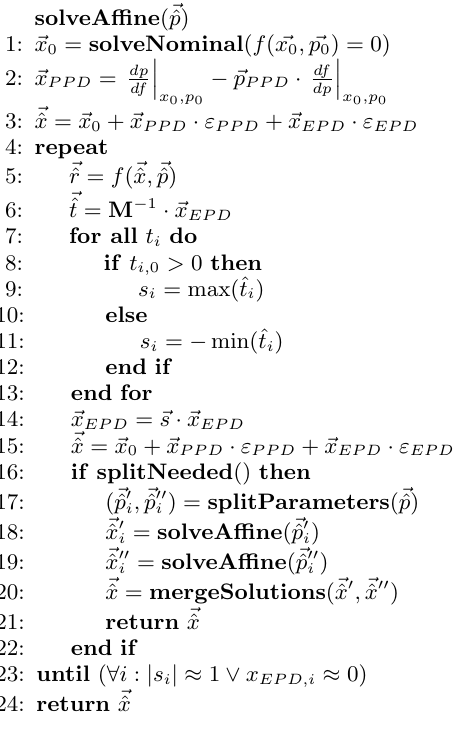
Figure 1: Affine solving algorithm with splitting